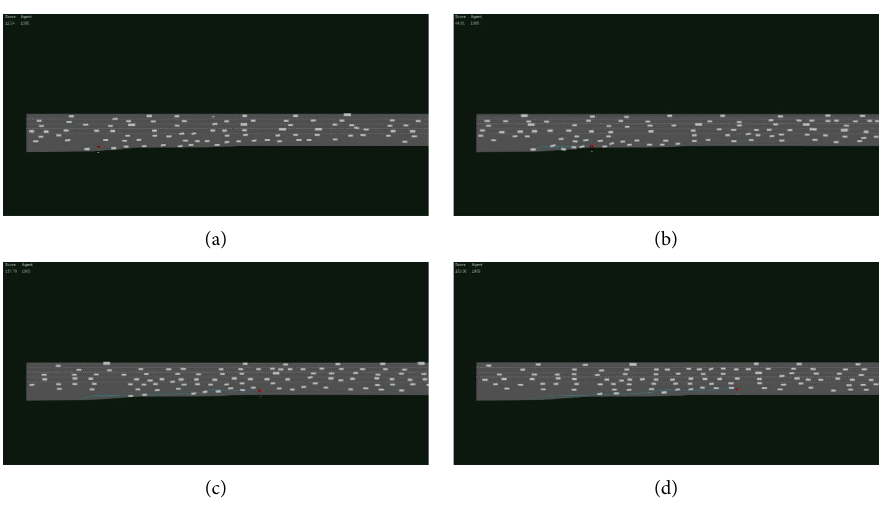
Figure 10: Simulation 2. (a) Keyframe 1. (b) Keyframe 2. (c) Keyframe 3. (d) Keyframe